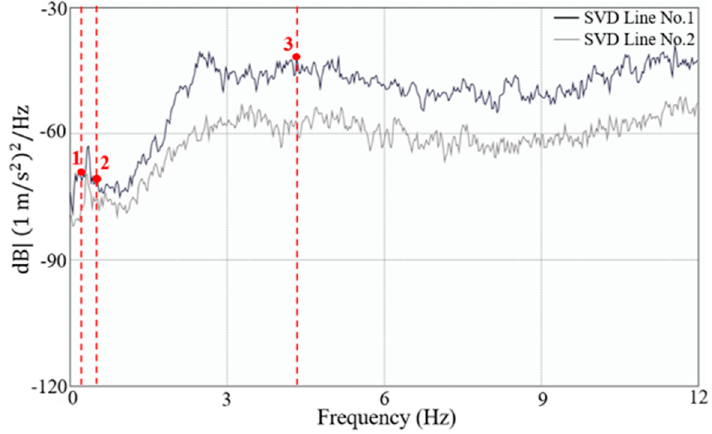
Figure 21. EFDD method: average normalised singular values of the spectral density matrices regarding Intercity standard seat.